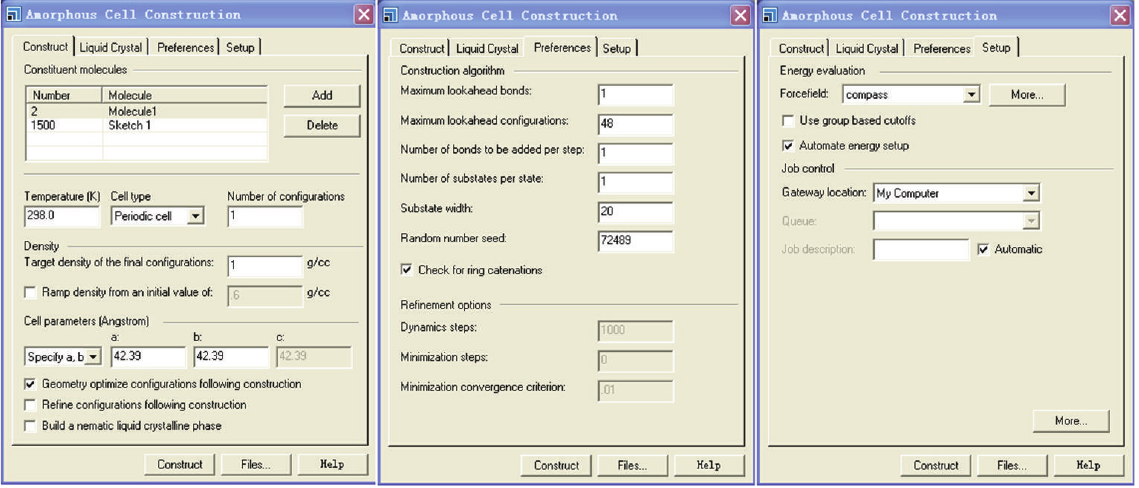
Figure 2: The details of the simulation parameters for setting up the simulation systems.